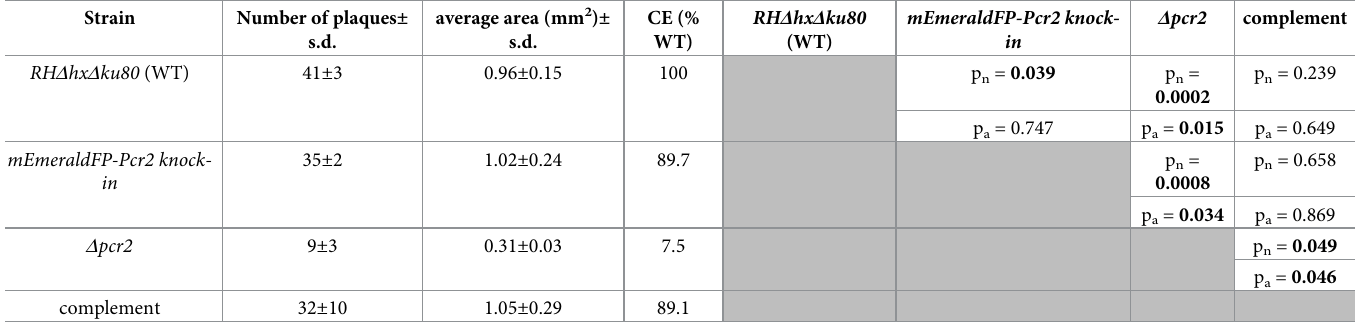
Table 1. Quantification of plaque assay for the four T . gondii strains. s.d.: Standard Deviation. Cytolytic efficiency (CE) = (Total area of the host cell monolayer lysed by a parasite line)/(Total area lysed by the WT parasite). P-values from unpaired Student’s t-tests are indicated on the right. P n : P-values for comparison of number of pla- ques. P a : P-values for comparison of average area of plaques. Strain Number of plaques ± average area (mm 2 ) ± CE (% Δ pcr2 RH Δ hx Δ ku80 mEmeraldFP-Pcr2 knock- s.d. s.d. WT) (WT) in